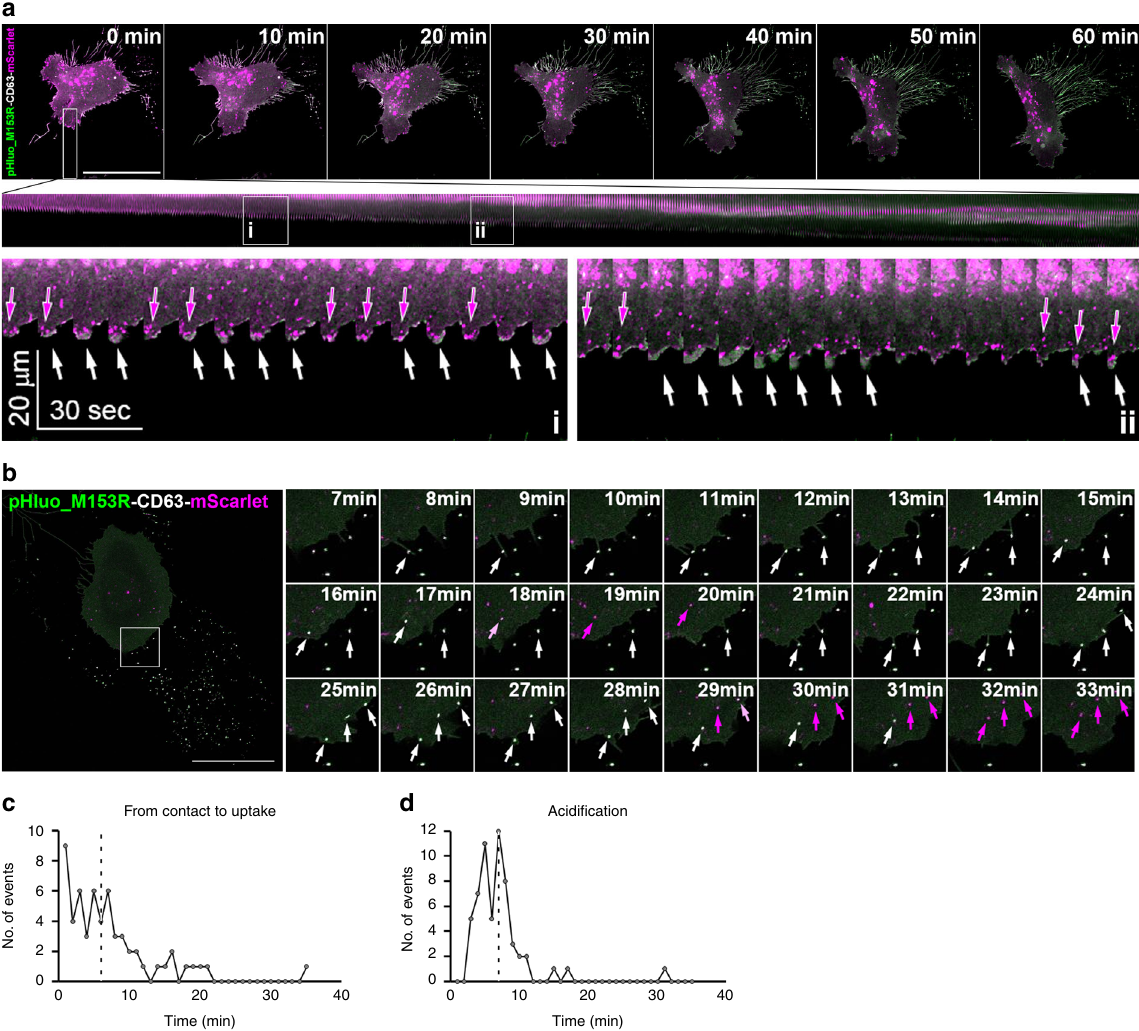
Fig. 7 Dual reporter reveals MVB transport before fusion and endosome acidi fi cation after uptake. Live confocal microscopy was used to image pHluo_M153R-CD63-mScarlet-expressing HT1080 cells. a Representative of 35 cells from four independent experiments. Top: Images were captured at 10 s intervals for 60 min (see Supplementary Movie 6). Time-series images with 10 min intervals show frames at the beginning and end of the movie, with the rectangle across the leading edge in the 0 min frame indicating location from which the kymograph (middle) was derived. pHluo_M153R-CD63 and CD63-mScarlet are shown in green and magenta, respectively. Scale bar, 50 µ m. Middle: Kymograph shows events over time across the indicated rectangle. Two regions (i and ii) selected from kymograph (middle) are enlarged at the bottom of the panel. Magenta arrows in kymograph zooms indicate CD63-mScarlet-positive MVB traf fi cking and docking to protrusions while white arrows indicate MVB fusion and exosome secretion. b Time-series images from live confocal microscopy of pHluo_M153R-CD63-mScarlet-expressing HT1080 cells with 1 min intervals from Supplementary Movie 7. White arrows indicate examples where fi lopodia contact exosome deposits. Magenta arrows indicate acidi fi ed exosome-containing endosomal compartments after exosome uptake. pHluo_M153R-CD63 and CD63-mScarlet are shown in green and magenta, respectively. n = 58 exosome uptake events from ten cells from fi ve independent experiments. Scale bar, 25 µ m. c Quantitation of internalization time of exosome deposits after initial fi lopodial contact from ( b ). Median time from contact to uptake is marked by a dotted line. d Quantitation of time from exosome endocytosis to acidi fi cation as shown in ( b ). Median time of acidi fi cation is marked by a dotted line. Source data are provided as a Source Data fi